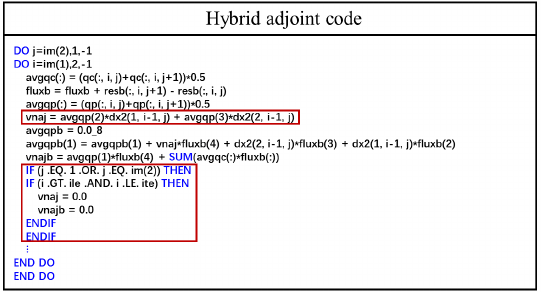
Figure 7. The hybrid adjoint codes corresponding to the calculation of convective